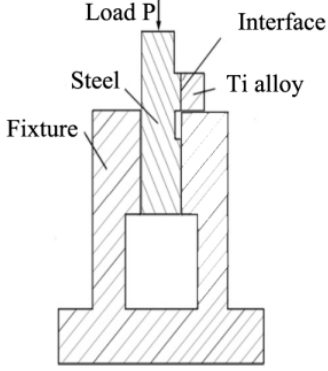
Figure 2. Schematic illustration of shear test apparatus.